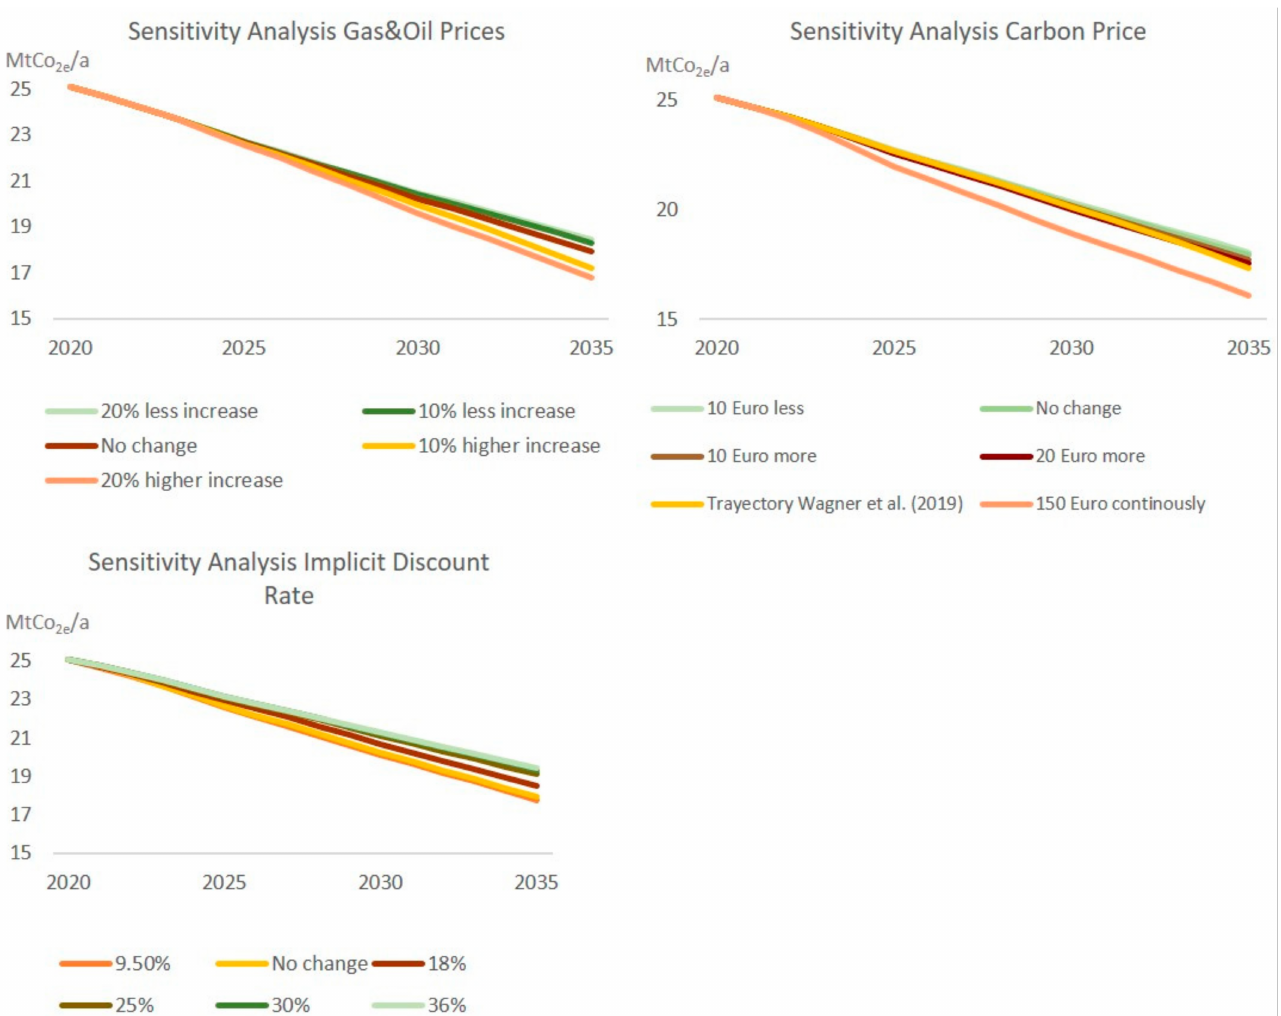
Figure 4. Results of the sensitivity analysis for Oil and Gas prices, carbon price and the implicit discount